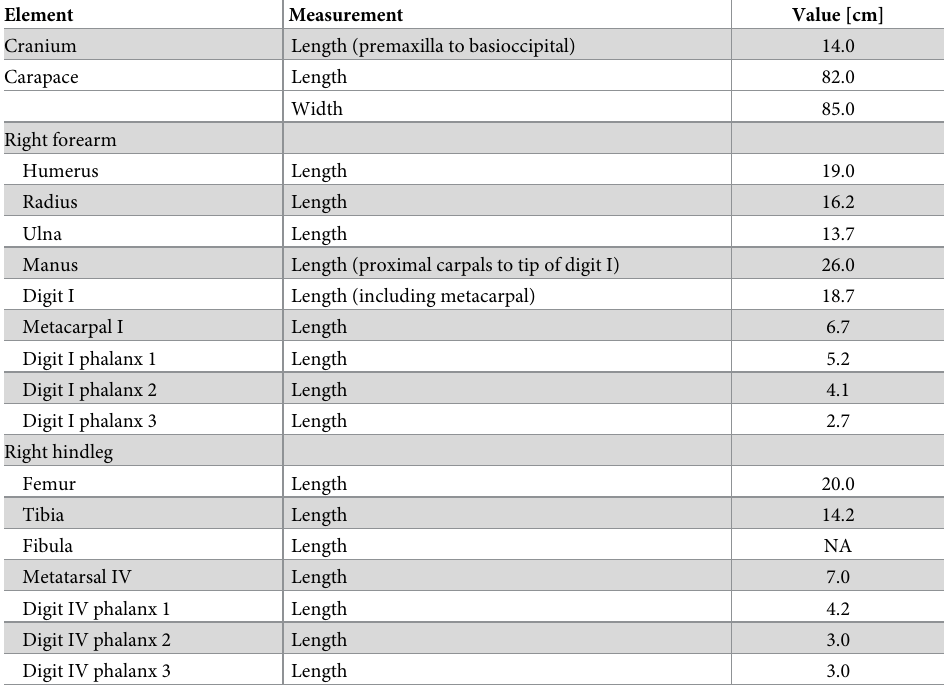
Table 1. A selection of basic measurement of NKMB